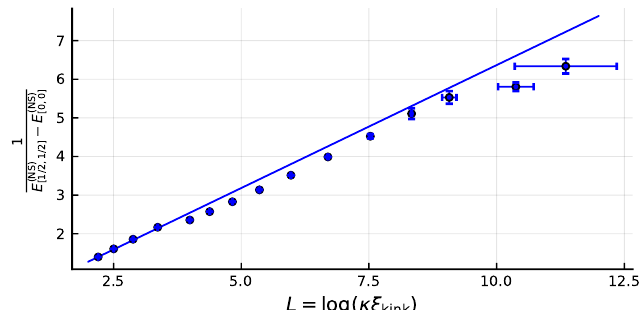
Figure 5 . The inverse gap between the first two eigenvalues of the entanglement Hamiltonian in the trivial sector as a function of L = log( κξ kink ) . The error bars on the singular values are obtained in a similar fashion to those of the inverse correlation length (see figure 3). The blue line is the CFT prediction 2 L and describes the extrapolated data well for κ ≈ 2 . 83 π